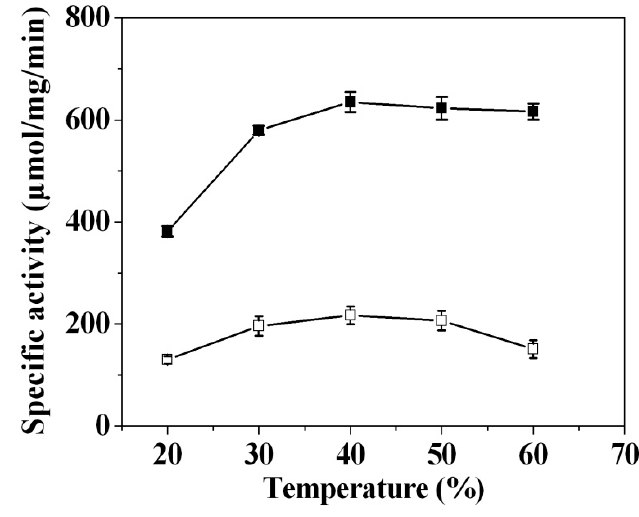
Figure 4. Temperature stability of laccase entrapped by protocol I ( ■ ) and free laccase ( □ ).